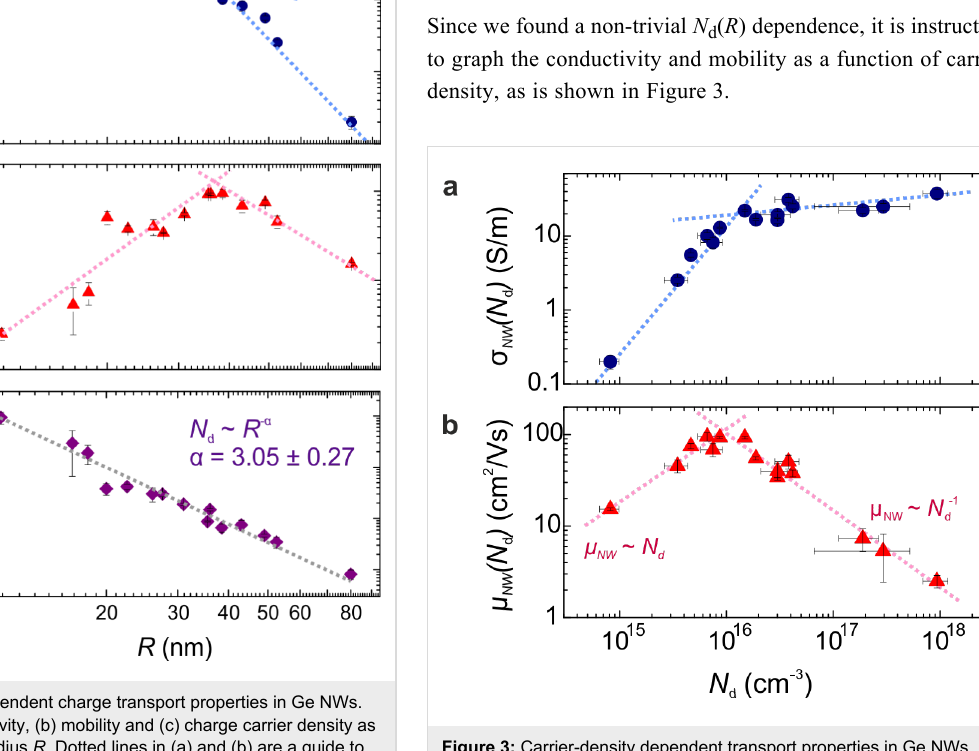
Figure 3: Carrier-density dependent transport properties in Ge NWs. (a) Electrical conductivity and (b) mobility as function of carrier density N d . Dashed lines are a guide to the